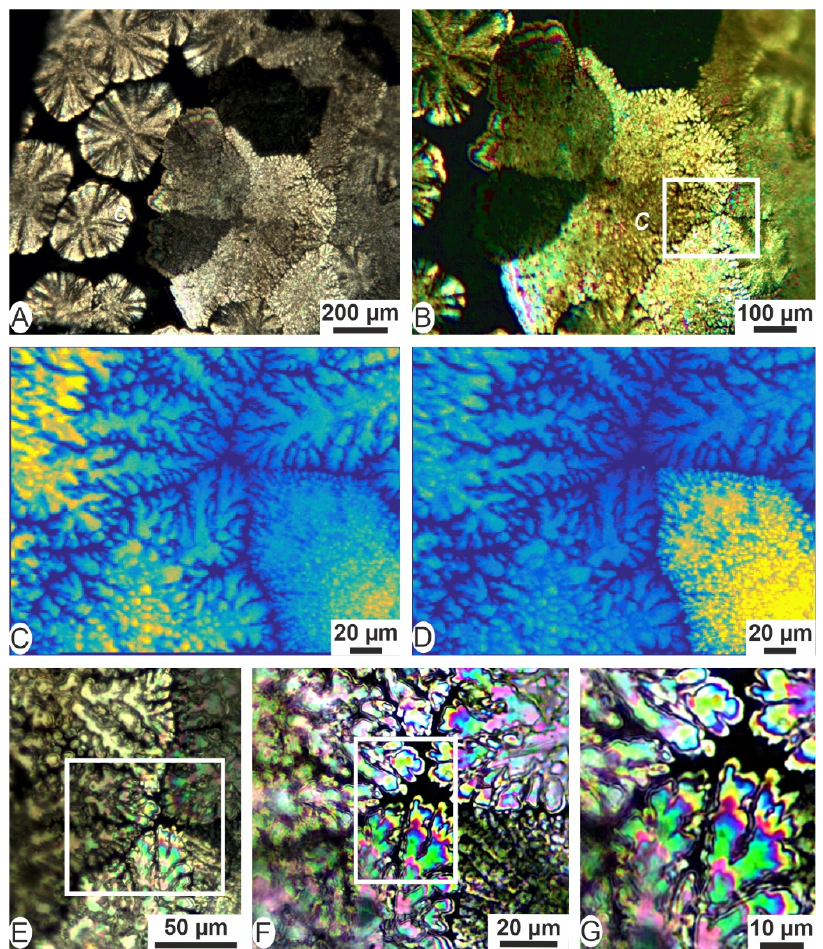
Figure 5. Structure of the mineralized units at the end of the graft expansion phase. ( A , B ) Each mineral unit viewed by optical microscopy (polarized light) exhibits distinct morphological and polarization patterns. ( C , D ) Ca ( C ) and Sr ( D ) HR ‐ X ‐ ray fluorescence of the selected area of Figure 2B (area C). ( E – G ) Polarization microscope view of the central part of the selected area; structures revealed by X ‐ ray fluorescence are built by a branching crystallized material.